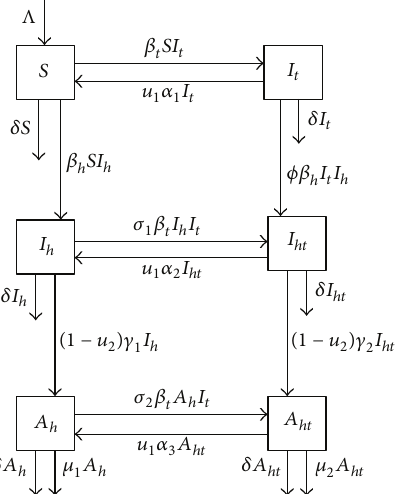
Figure 1: TB-HIV coinfection transmission